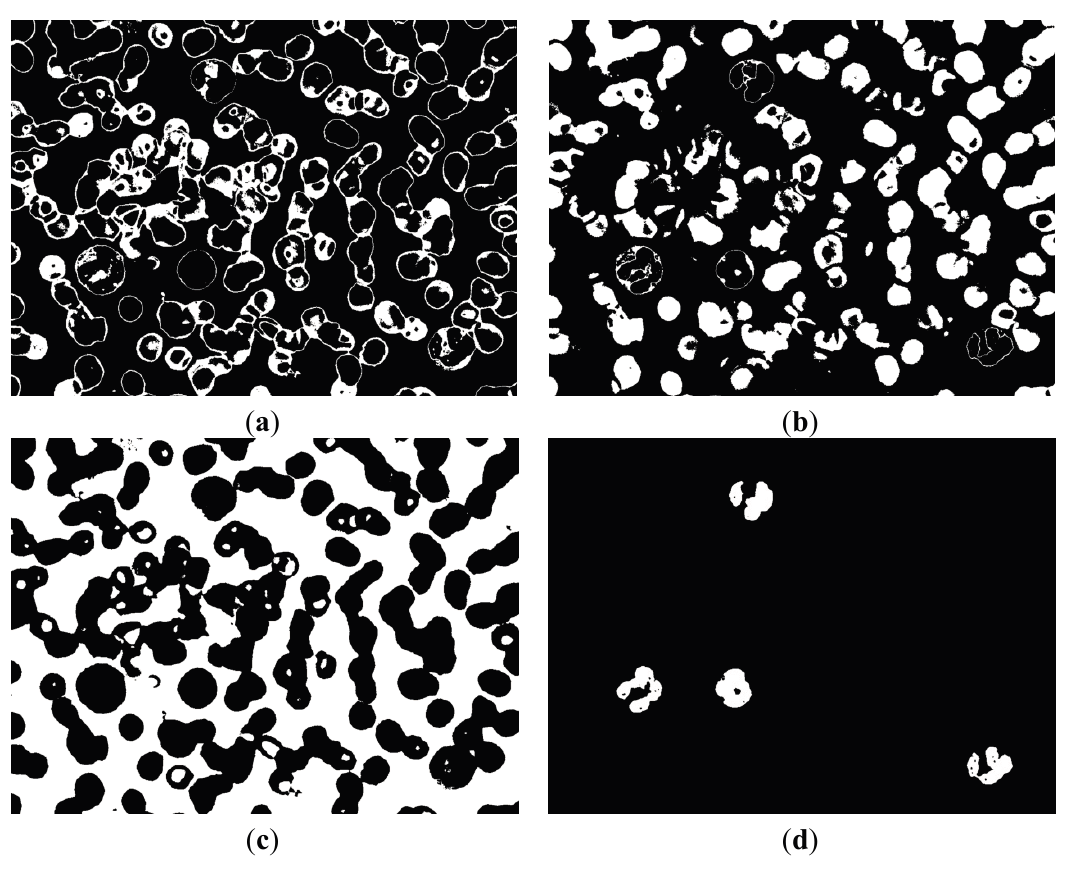
Figure 10. Clustering results of (cid:1835)